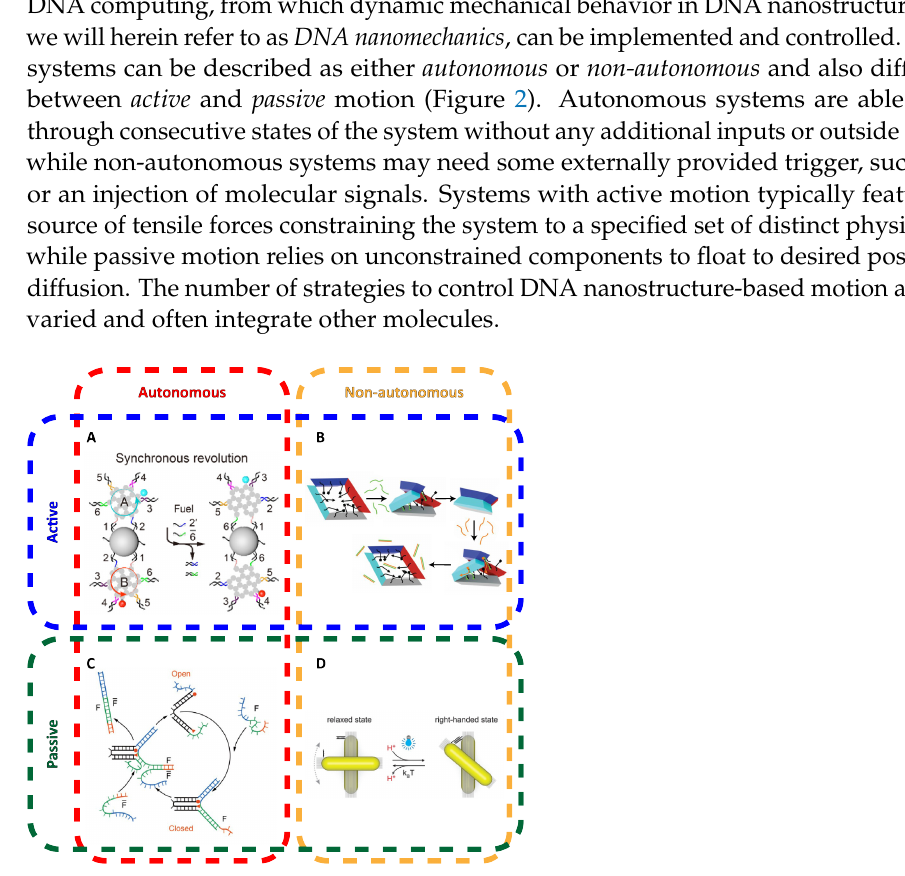
Figure 2. Examples of classes of dynamic DNA systems. ( A ) A gear-like system resembles the motion of a DNA walker upon a track embedded upon the surface of a gold nanoparticle. The system autonomously transitions between physical states of rotation with respect to the central gold nanoparticle by consuming ssDNA fuel (reprinted with permission from AAAS [53]); ( B ) The operation of a DNA origami Bennett linkage has defined physical conformations but requires an injection of strands to progress the state of the system via strand displacement (reprinted with permission from National Academy of Sciences [54]); ( C ) A DNA tweezer cycles between opened and closed states by consuming fuel. Its closed state is enforced by the rigidity of duplex DNA. However, without any mechanical stress to bias the opened state, the system only reaches the state via diffusive movement of its components (reprinted with permission from Springer Nature [55]); ( D ) The rotational configuration of two gold nanorods attached to their respective DNA origami bundles is controlled by an external light source that affects the formation of a DNA triplex link between the bundles. While the link is inactive, the angular relationship between the nanorods is no longer fixed as the components will rotate in the relaxed state (reprinted with permission from Wiley-VCH